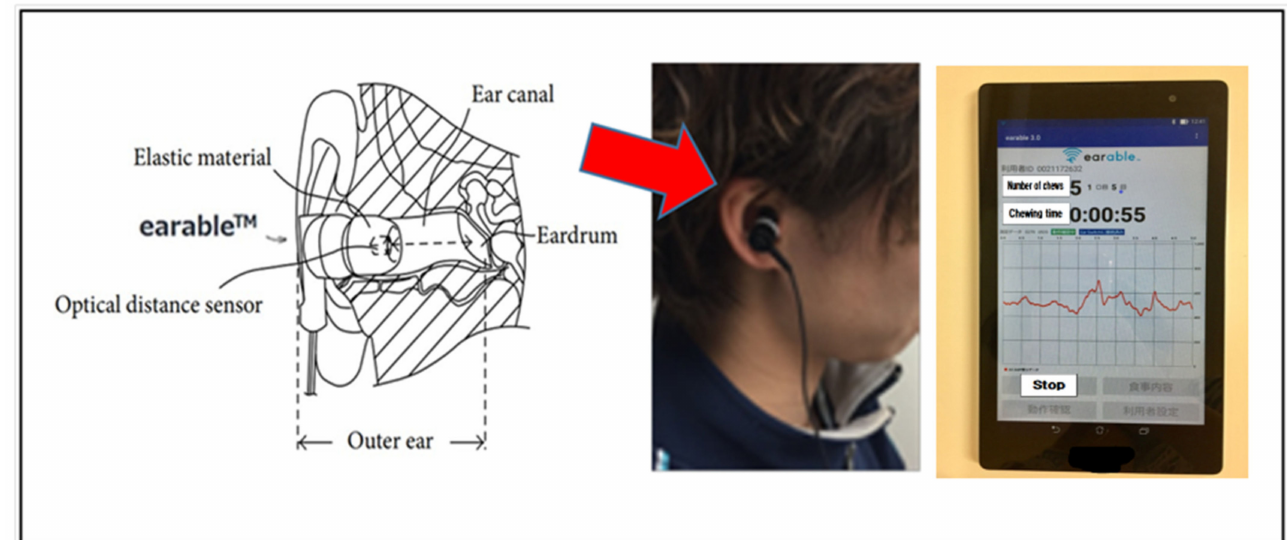
Figure 1. Structure of the earable, a diagram of it in use, and what it displays on a tablet. A goodness-of-fit index of 0.958 or greater, as well as a recall index of 0.937 or greater, have both been reported for this device, indicating that there is a high likelihood that it accurately counts the number of chews